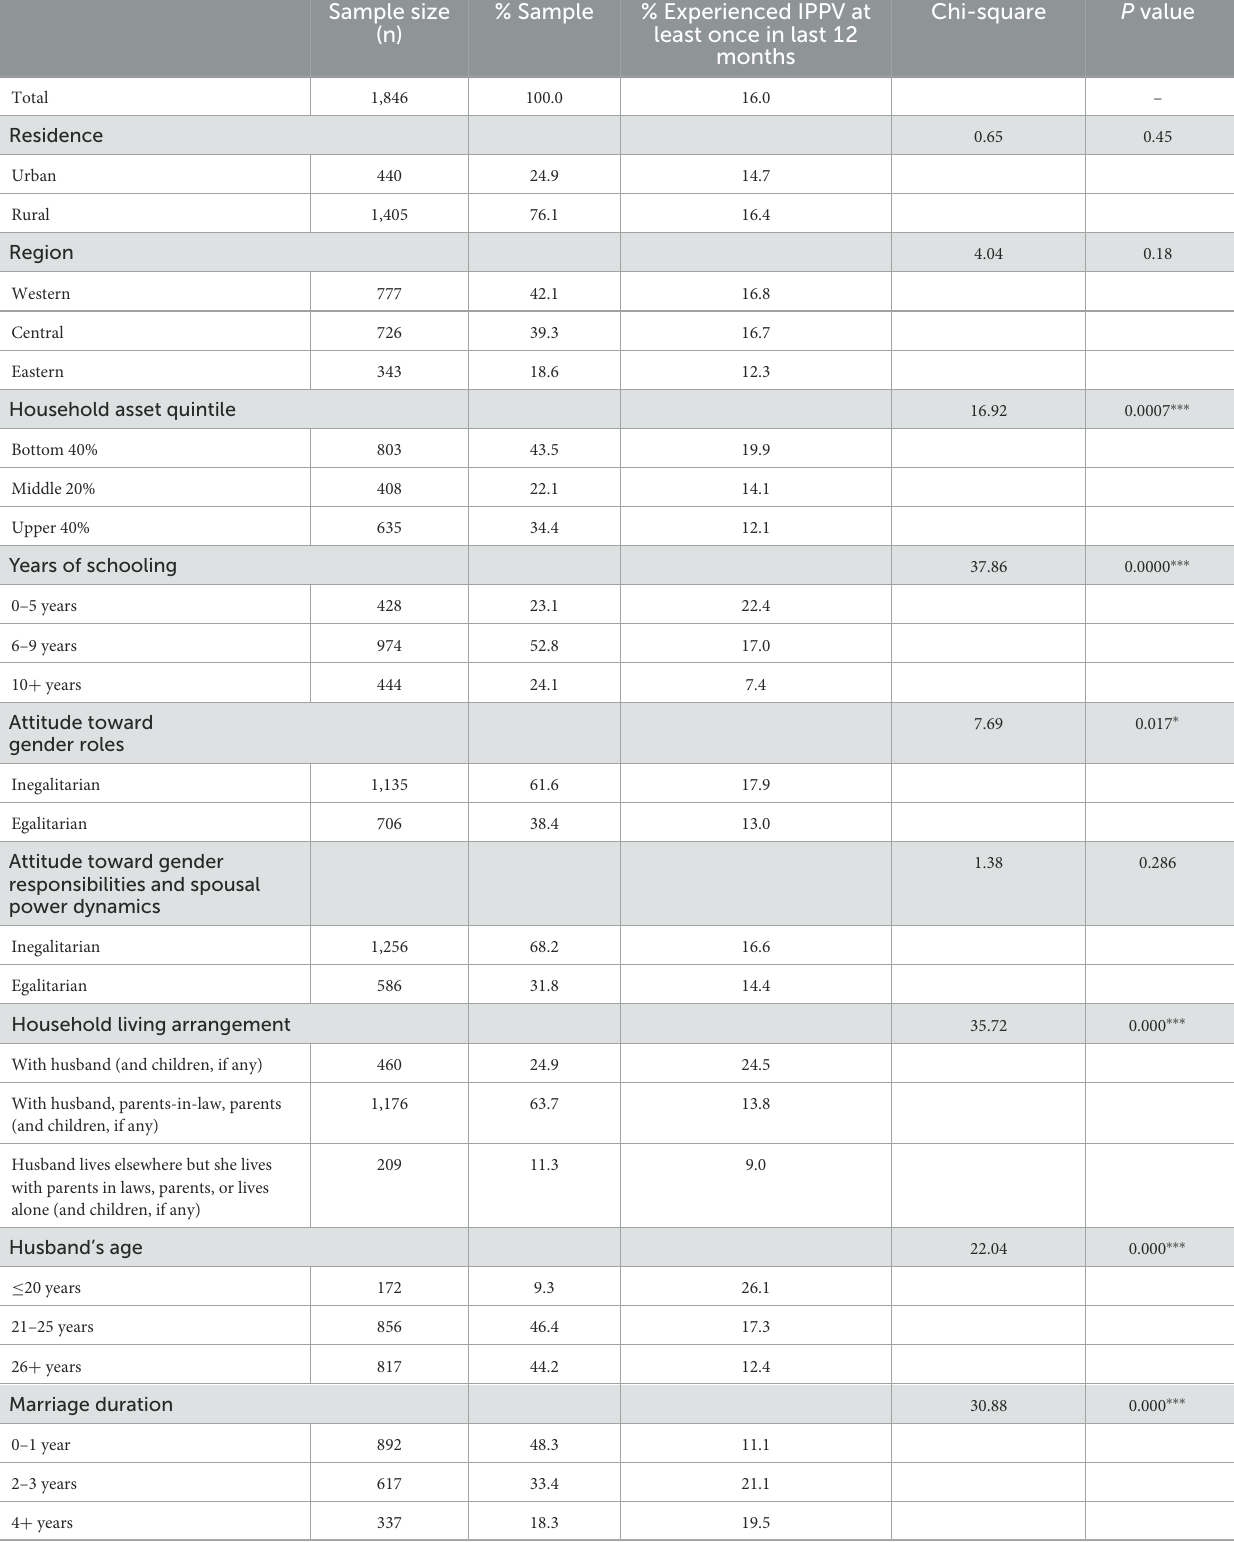
TABLE 2 Description of sample of currently married adolescents ages 15–19 who are exposed to IPPV, Bangladesh Adolescents Health and Wellbeing Survey